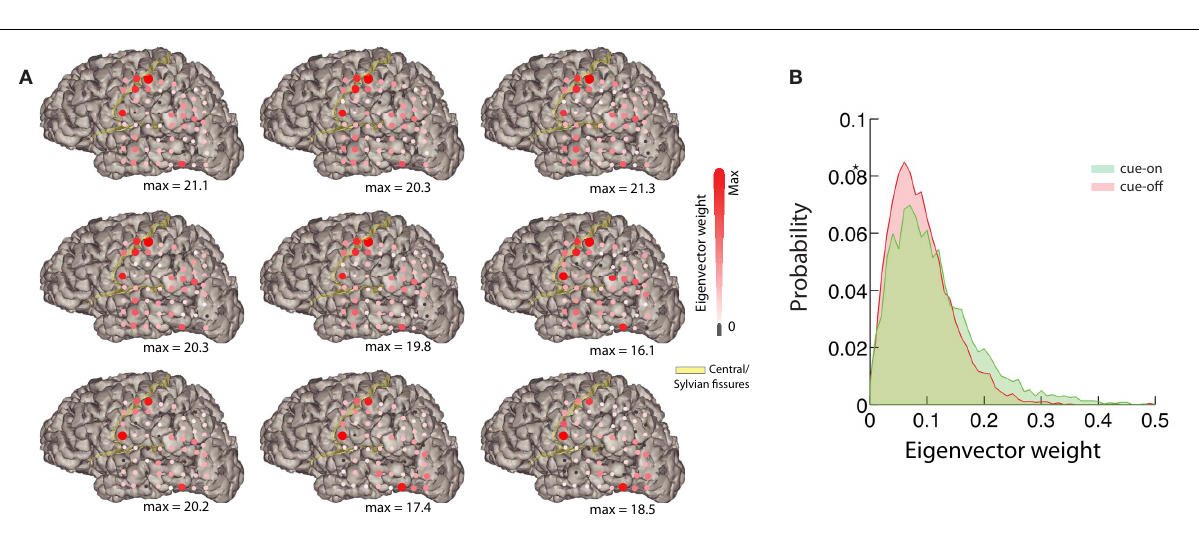
the difference between conditions (eigenvector weight).The maximum difference is indicated below each subplot.The position of the red circles correspond to the position on the brain of each electrode of the array for this subject. (B) We show the eigenvector weight distribution for most unstable eigenvector and the component with larger difference between